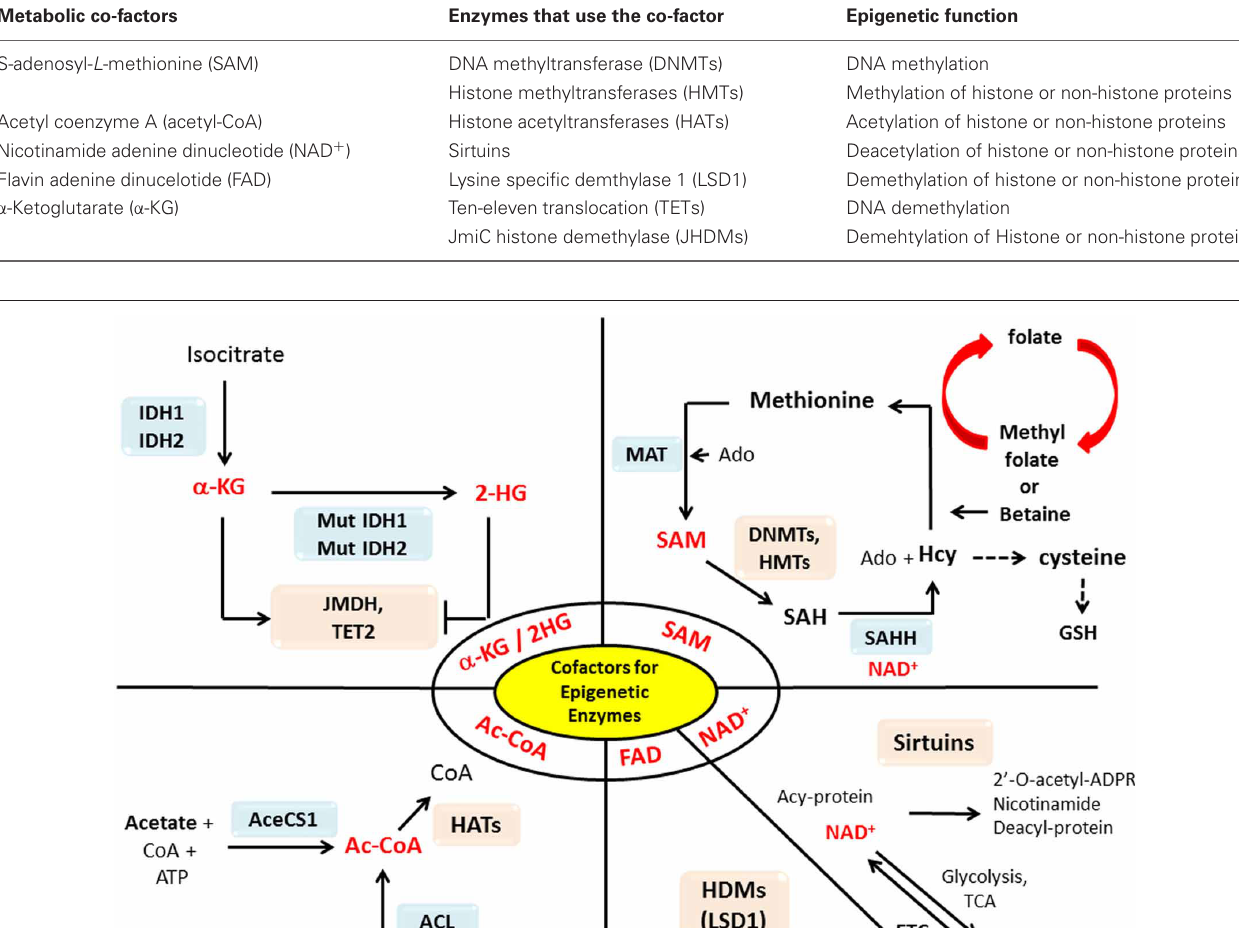
Table 1 | Link between metabolism and Epigenetics through metabolic co-factors.